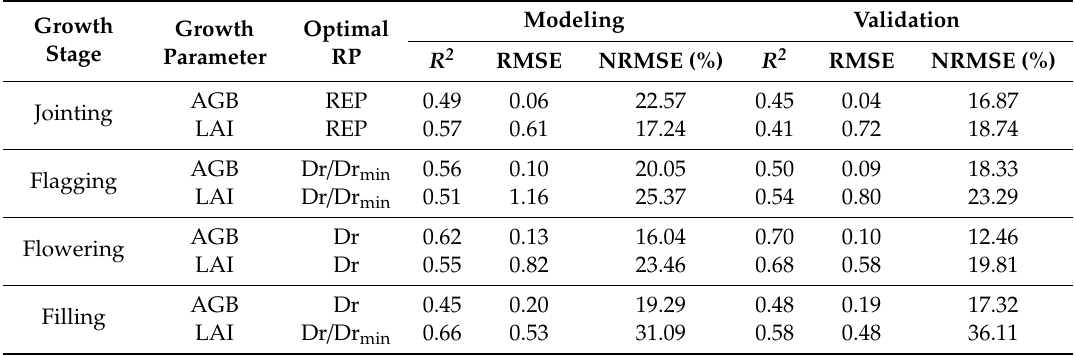
Table 5. Performance metrics for the estimates of winter-wheat growth parameters (AGB and LAI) obtained using the optimal red-edge parameters for di ff erent growth stages.